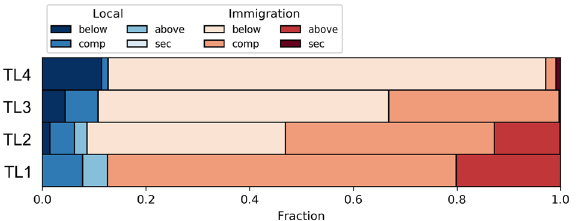
Figure 6. Extinction causes for species on different trophic levels, again for a system of 400 habitats and a dispersal rate of 10. Blue shades refer to local processes, i.e., to speciation events, red shades refer to processes triggered by immigrants from neighbouring habitats. We sort events into classes depending on whether the change occurs in the same trophic level (competition) or in the trophic level below or above. ‘Sec’ denotes secondary extinctions, which occur as the result of a preceding extinction in the same simulation step. Basal species are mostly affected by incoming competitors, whilst higher trophic species are more sensitive to all kind of changes in the network, e.g. a rearrangement in the lower trophic